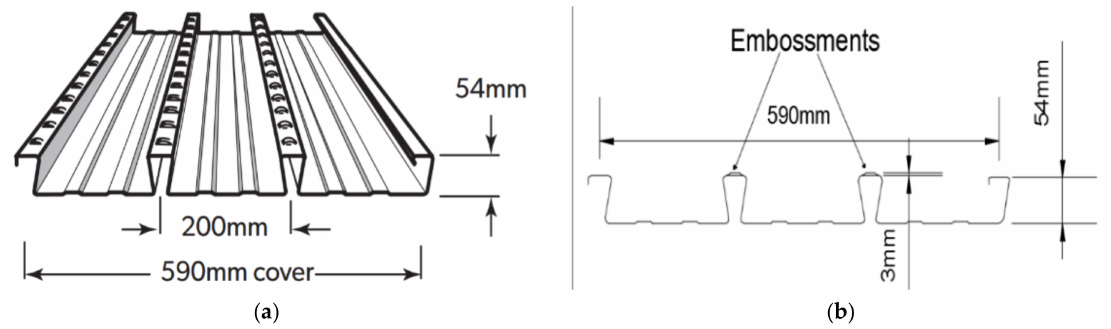
Figure 2. Size distribution analysis of fine aggregate used.